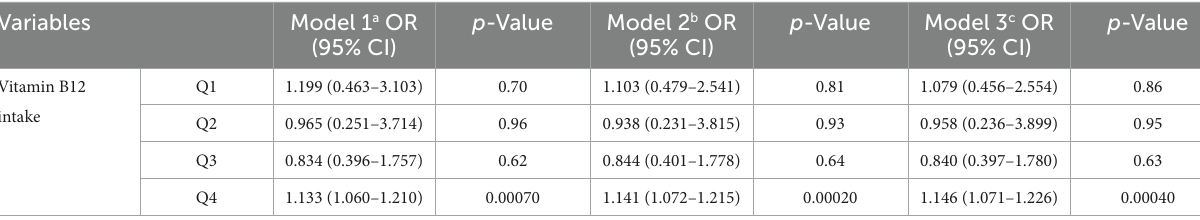
TABLE 3 Association between vitamin B12 intake levels and glaucoma in different quartiles.